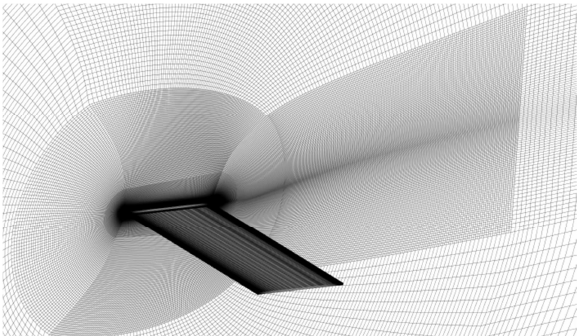
Fig. 2 . Detail of the cut-cell refined mesh in the vicinity of the flat plate.